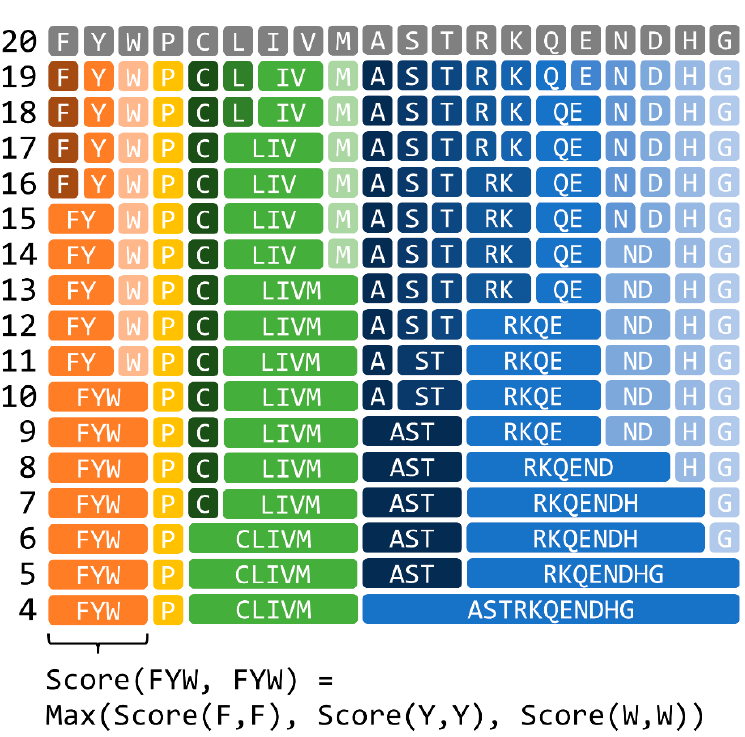
Figure 1. Reduced amino acid alphabet generated using the method proposed by Murphy et al. [9].